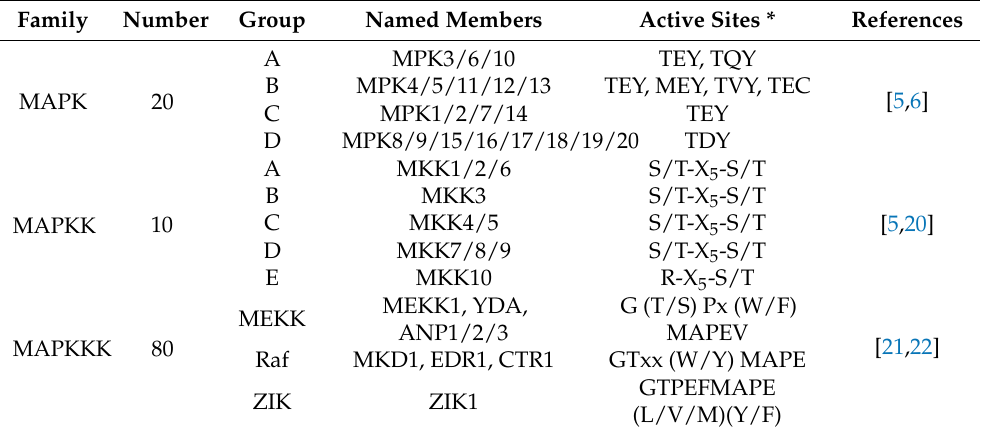
Table 1. Composition and classification of MAPK cascades in